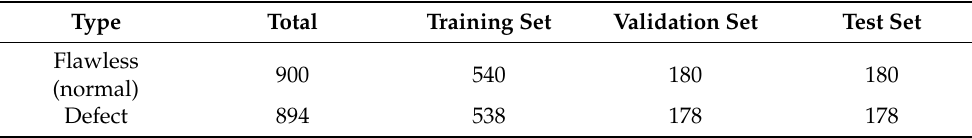
Table 3. Dataset Set Distribution for